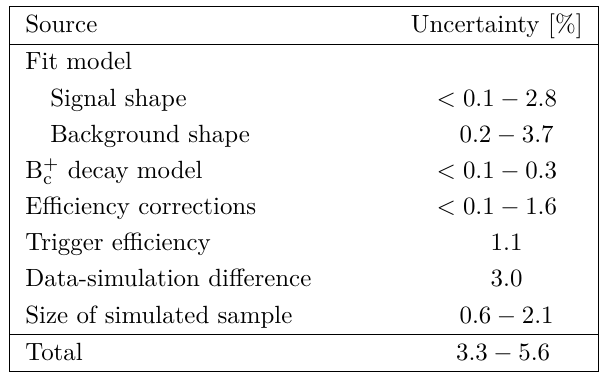
Table 3 . Ranges of relative systematic uncertainties for the ratios of branching fractions R X The total systematic uncertainty is the quadratic sum of individual